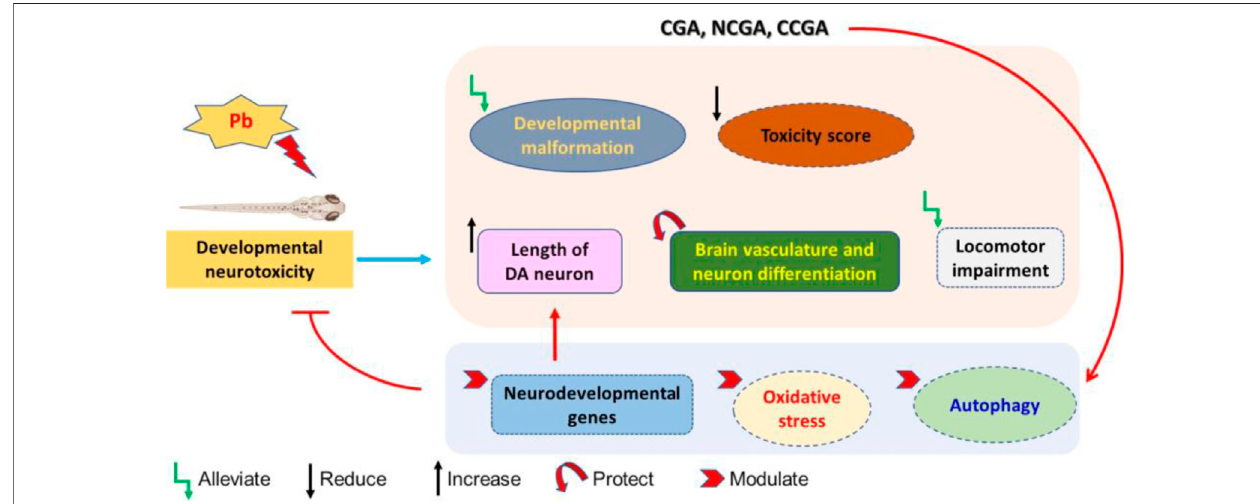
FIGURE 10 | Schematic representation of protective effect of CGA, NCGA, and CCGA against Pb-induced developmental neurotoxicity co-treatment of CGA, NCGA, and CCGA alleviated developmental malformation, reduced toxicity score, increased the length of DA neuron region, protected brain vasculature and neuron differentiation in the CNS, ameliorated locomotor impairment, modulated neurodevelopmental genes ( c-fos , gfap , mbp , ppar c , tuba1b , bdnf , and dat ), oxidative stress- related genes ( sod2 , sod1 , cat , gclm , gsto2 , and gpx4a ), and parkinsonian and autophagy-related genes ( dj1 , pink1 , parkin , ambra1a , ulk1b , ulk2 , and atg5 ). Summing up, our study demonstrates that co-treatment with CGA and its analogues NCGA and CCGA protects against Pb-induced developmental neurotoxicity. The protective mechanism of CGA, NCGA, and CCGA co-treatment might not be only due to the inhibition of apoptosis also protection of brain vasculature but also due to the inhibition of Pb exposure induced oxidative stress and autophagy in zebra fi sh ( Figure 10 ). Our results provide proof of concept that CGA, NCGA, and CCGA might represent the future treatment against Pb